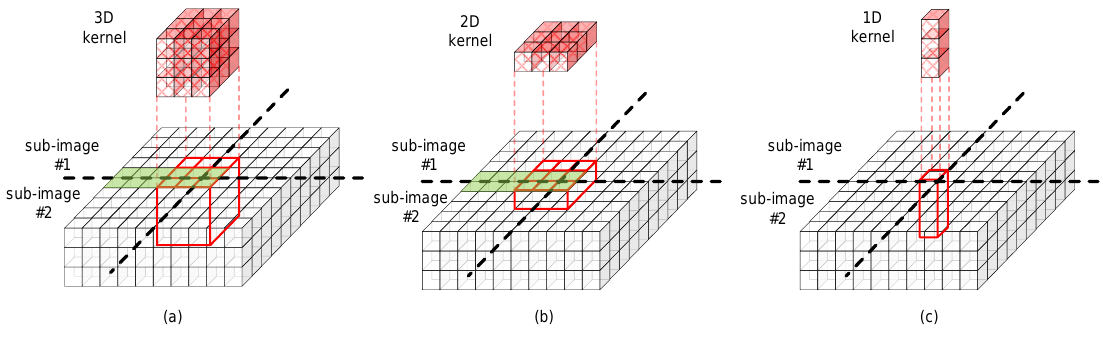
Figure 4. ( a ) The sub-image convolution with 3D kernels. ( b ) The sub-image convolution with 2D kernels. ( c ) The sub-image convolution with 1D kernels.